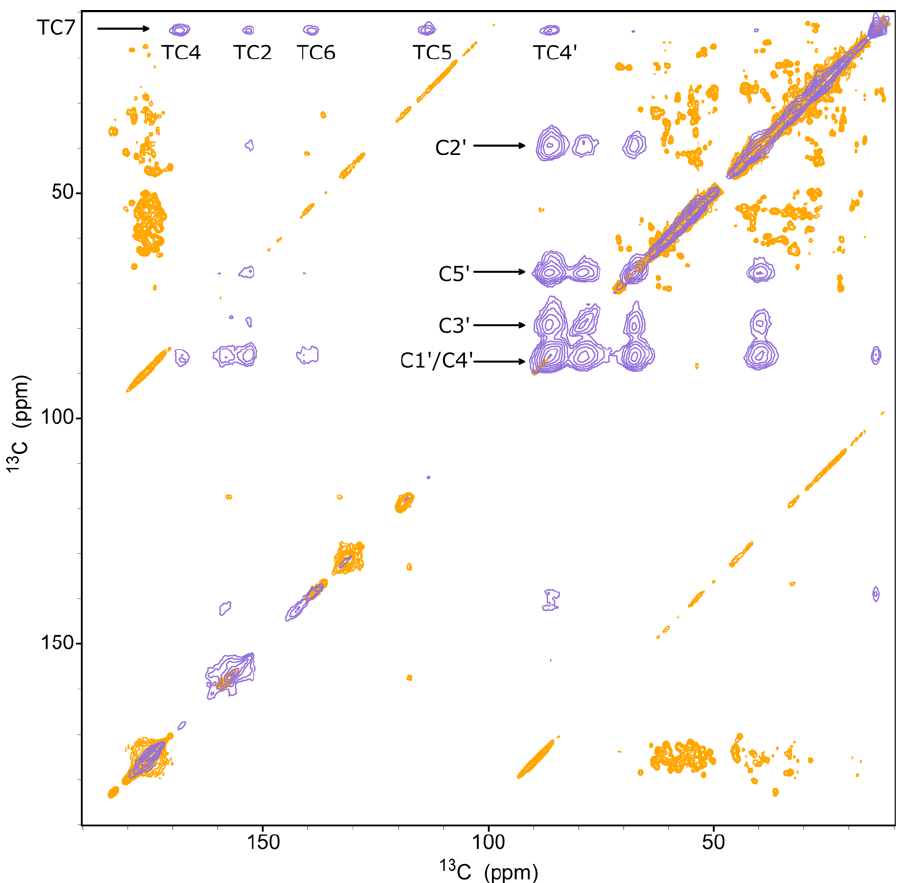
Figure 3. Spectral overlay of two 2D 13 C- 13 C DARR spectra of U-gVp/NA-DNA (orange) and of NA- gVp/U-DNA (blue). The mixing times were 5 ms and 100 ms, respectively. Signals of the unlabeled protein are observed on the diagonal of the blue spectrum, where many correlations are observed in the orange spectrum, including the aliphatic and carbonyl protein-unique regions. Signals due to correlations between ssDNA ribose sugar carbons (C1′–C5′) and of the thymine methyl group (TC7) with other base carbons (TC2, TC4, TC5, TC6) and with C4′ are marked. Weaker thymine base–sugar correlations with C1′/C4′ are also visible.